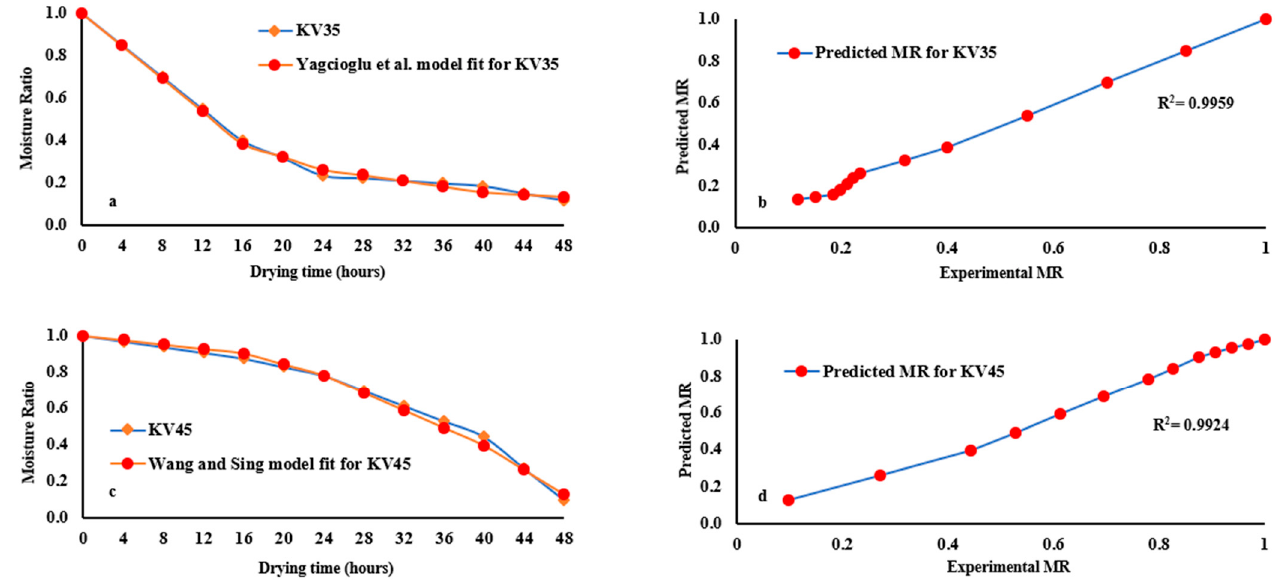
Figure 5. Experimental and predicted drying curves of KV35 and KV45 ( a – c ) and comparison of the experimental MR and predicted MR of KV35 and KV45 ( b – d ) using best-fit models.